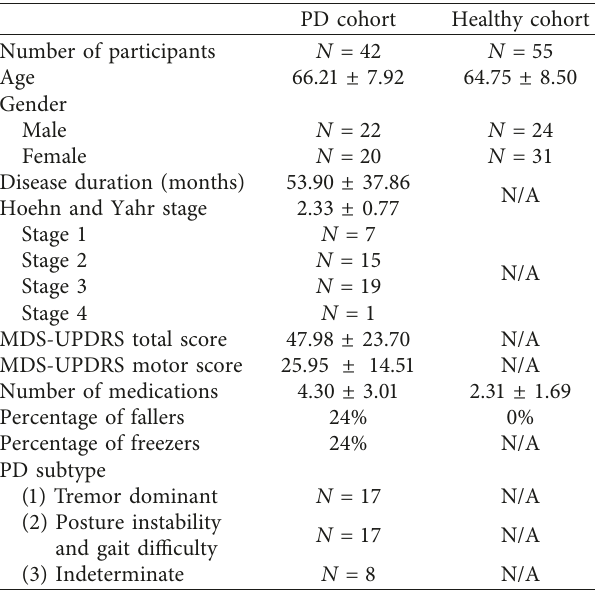
Table 2: Demographics for Parkinson’s disease cohort and age- matched healthy